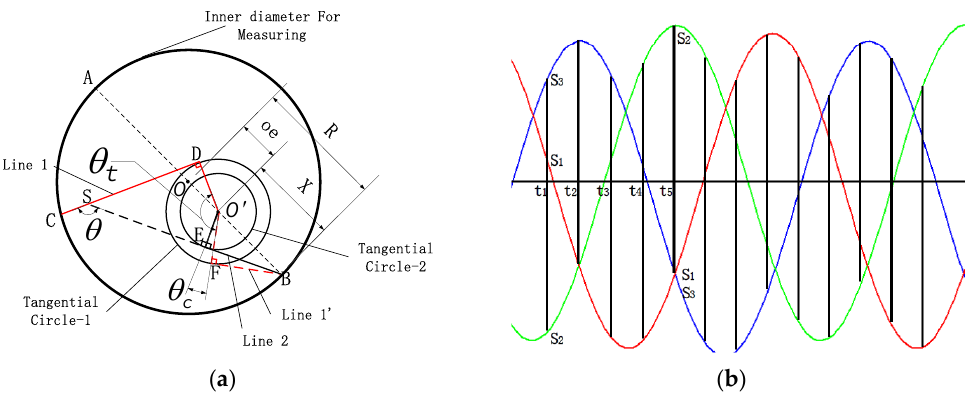
Figure 4. ( a ) Calibration principle of beam angle 𝜃 ; ( b ) Sensor output waveform.